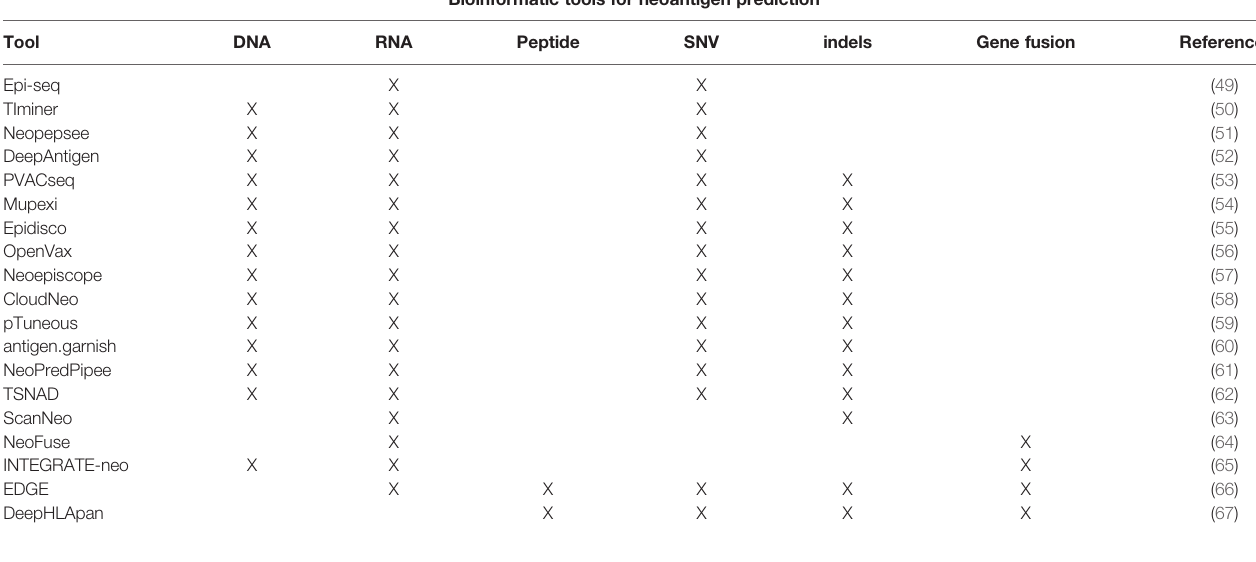
Bioinformatic tools for neoantigen